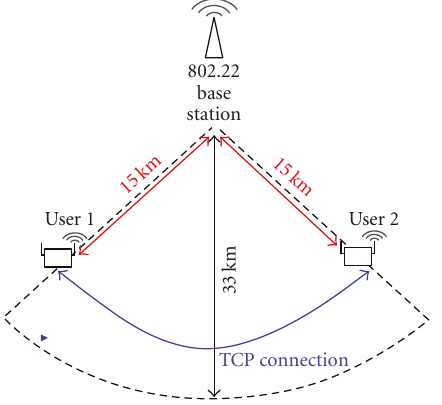
Figure 4: Simulation environment.